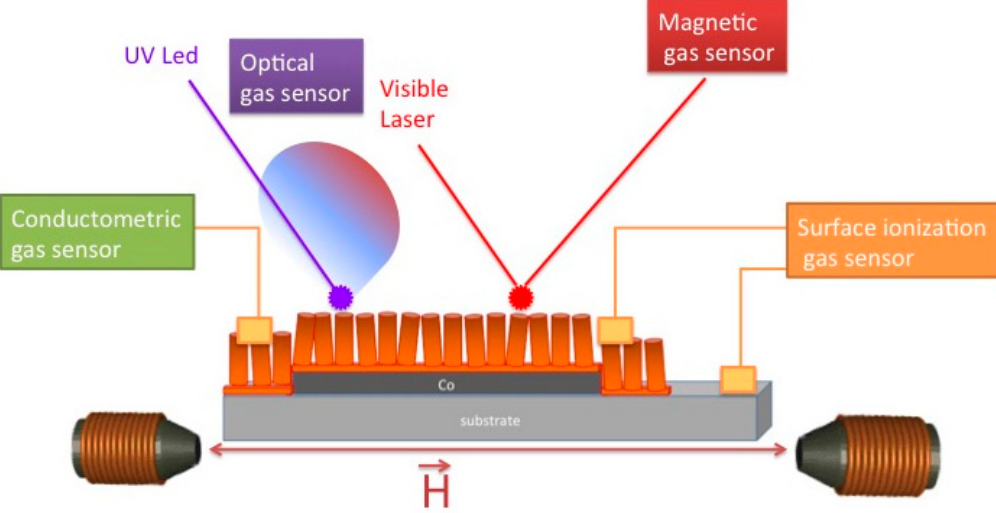
Figure 13. Scheme of multisensor chip for gas detection merging electrical, optical, magnetic, surface ionization sensing.